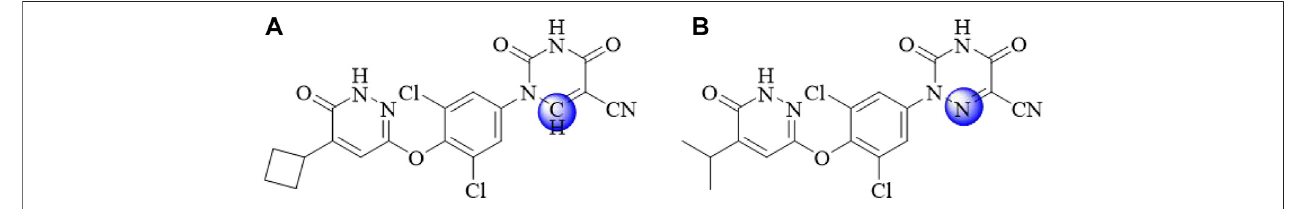
FIGURE 1 | The chemical structures of YWS01125 (A) and MGL-3196 (B) .